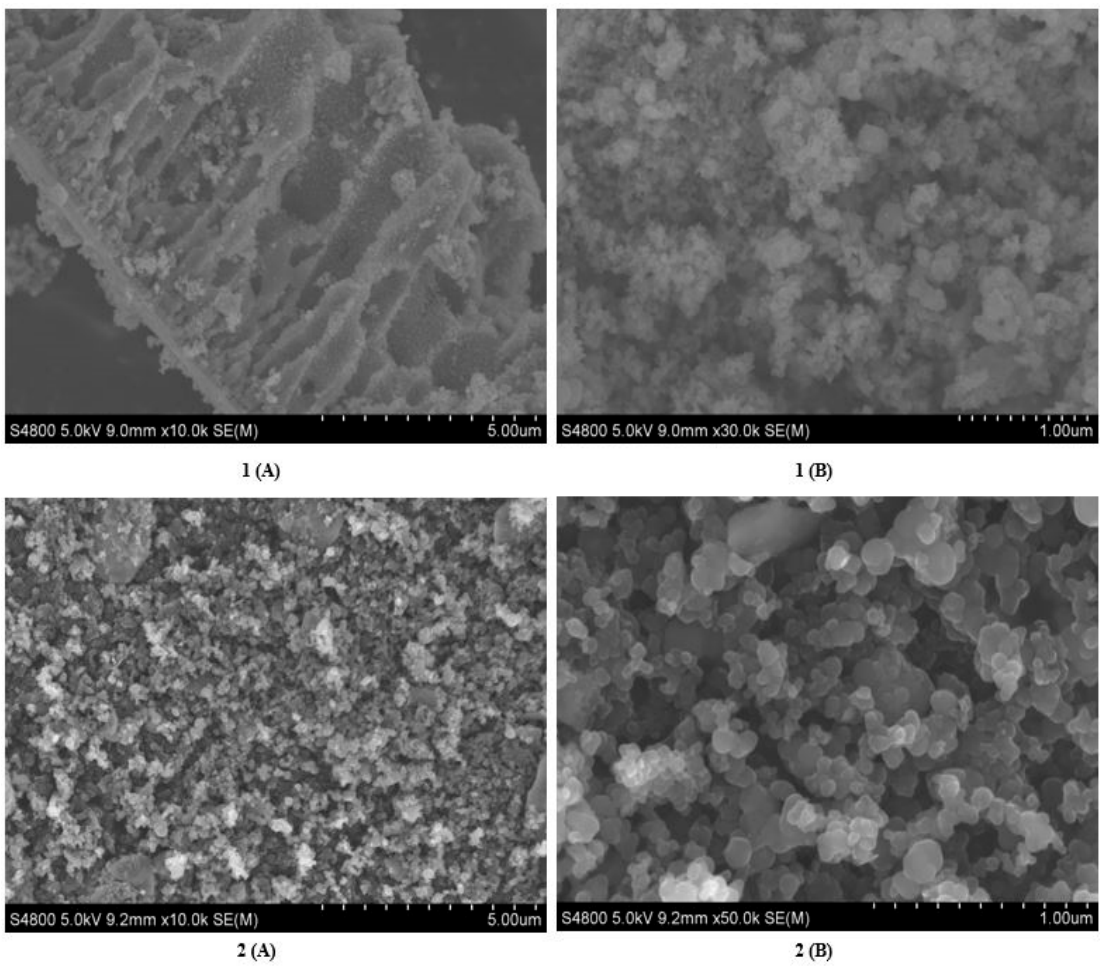
Figure 1. XRD pattern of TiO 2 nanoparticles and N-doped TiO 2 nanoparticles.